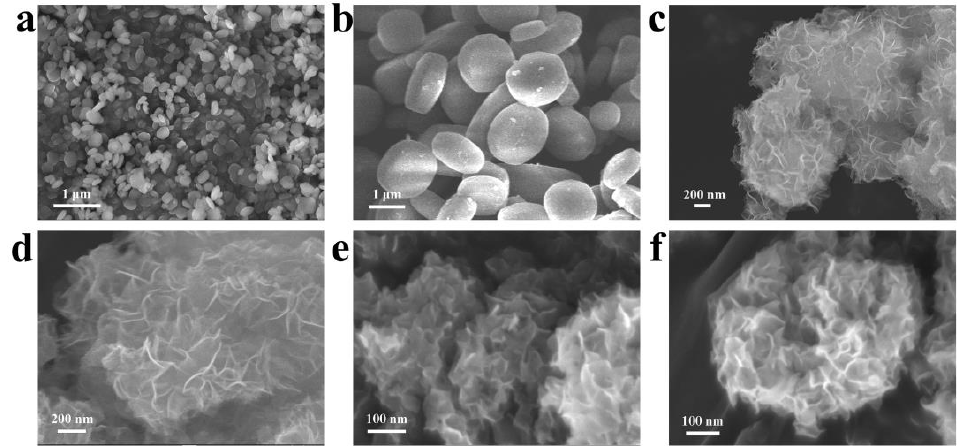
Figure 2. SEM images of ( a , b ) NH 2 -MIL-125; ( c , d ) PTOC and ( e , f ) PtNi/PTOC catalyst.